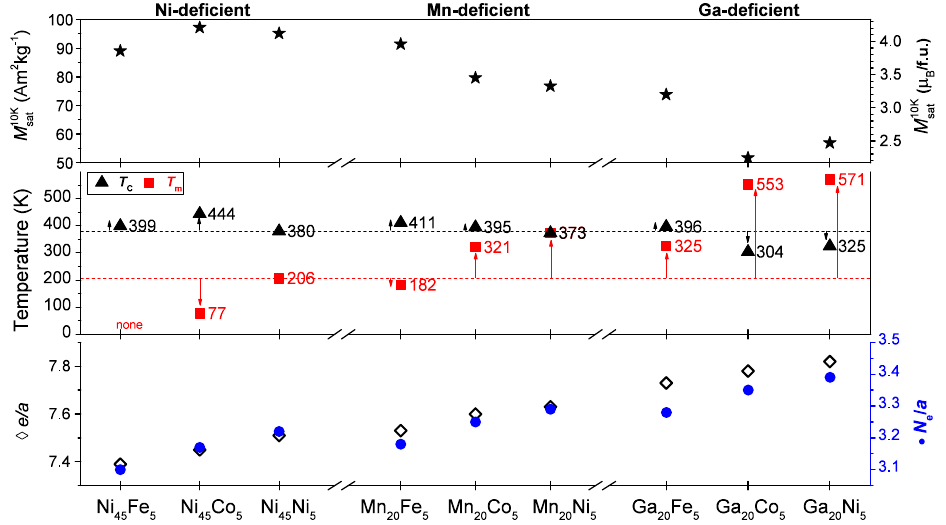
Figure 7. Transition temperatures dependences on composition rearranged according to a doping site. In addition, saturation magnetization M 10K and e/a and N e / a parameters are plotted for comparison. sat The dashed lines mark transition temperatures of the stoichiometric alloy, and the arrows emphasize a temperature deviation from